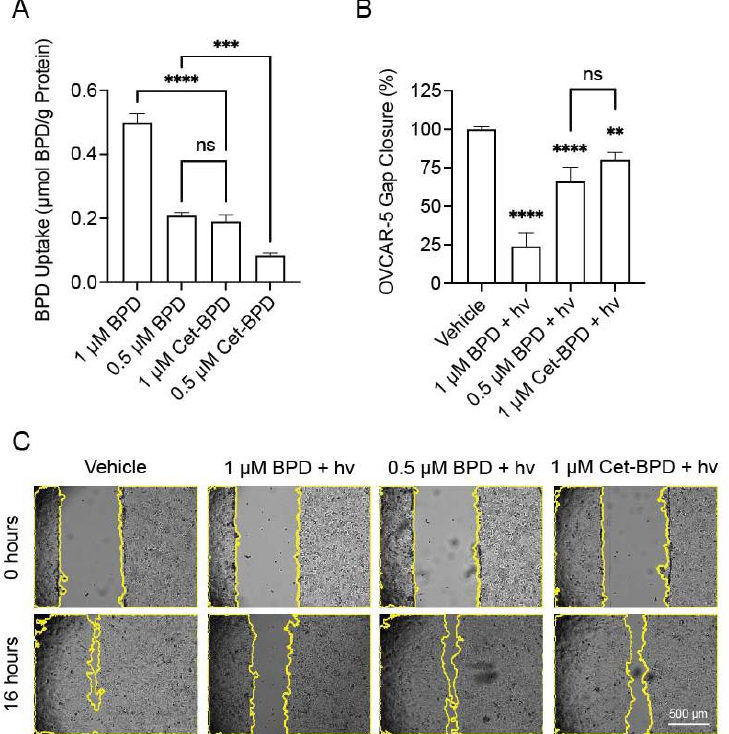
Figure 3. Conjugation of BPD to cetuximab impacts uptake and gap closure effects in ovarian cancer cells. OVCAR-5 cells were plated in 96-well plates, treated with the indicated BPD or Cet-BPD doses for 24 h, then ( A ) agents were extracted from cells to quantify cellular photosensitizer uptake, or ( B ) cells were light-activated at 690 nm and scratched for gap-closure analysis. Representative gap closure images are included ( C ). Statistical analysis was performed using a one-way ANOVA and post hoc Tukey’s test. Error bars represent the standard error of the mean. ** p ≤ 0.01; *** p ≤ 0.001; **** p ≤ 0.0001; ns: nonsignificant.